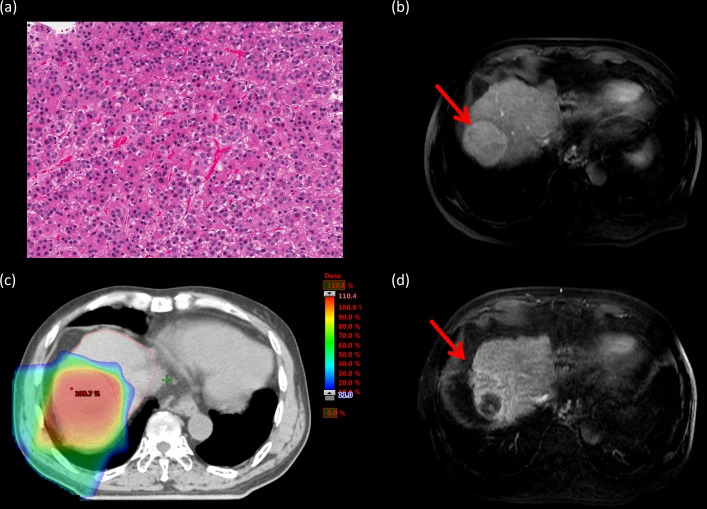
Tumor response of histopathologically proven hepatocellular carcinoma.a. Pathological specimen from one of our patients under H&E staining. b. Pretreatment magnetic resonance imaging (MRI) with contrast showing the primary tumor (red arrow). c. The patient underwent proton beam therapy (PBT). d. MRI with contrast 18 months after PBT. Shrinkage and loss of tumor viability of the primary tumor (red arrow).